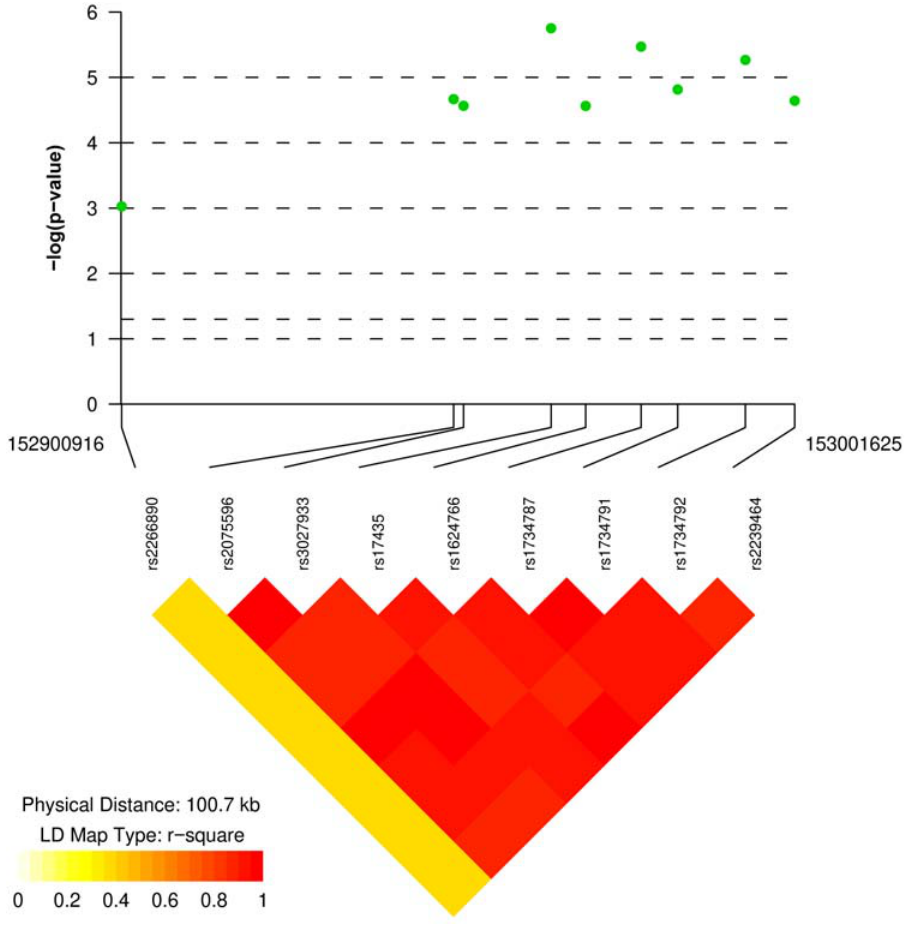
Figure 1. Allelic association results and linkage disequilibrium (LD) plot of the chromosome Xq28 region around the MECP2 gene. The allelic association p values of the SNPs analyzed are shown in the Korean cohort included in this